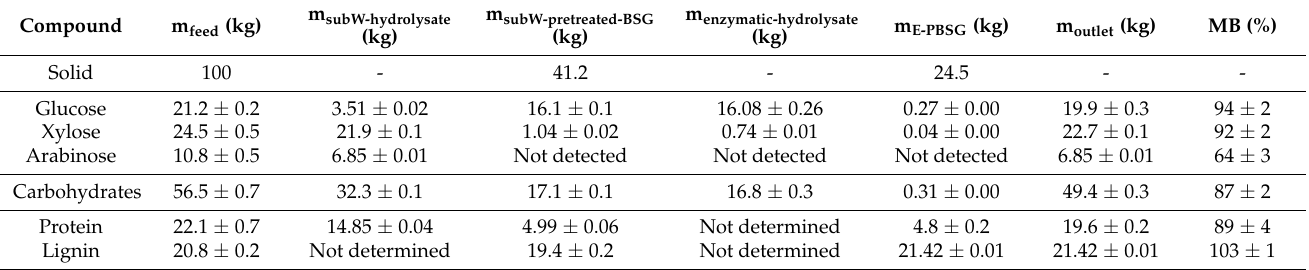
Table 4. Mass balance (MB) of subW hydrolysis at 5% ( w / v ) and subsequent enzymatic hydrol- ysis at 8% ( w/v ) solids loading from 100 kg of dry BSG. Mass of each compound in feed (m feed ), subcritical water hydrolysate (m subW-hydrolysate ), subW-pretreated BSG (m subW-pretreated-BSG ), enzy- matic hydrolysate (m enzymatic-hydrolysate ), solid residue remained after enzymatic hydrolysis of subW- pretreated BSG at 8% ( w / v ) solids loading (m E-PBSG ) and outlet mass (m outlet ) calculated as the sum of each compound in the different final streams (m subW-hydrolysate + m enzymatic-hydrolysate + m E-PBSG